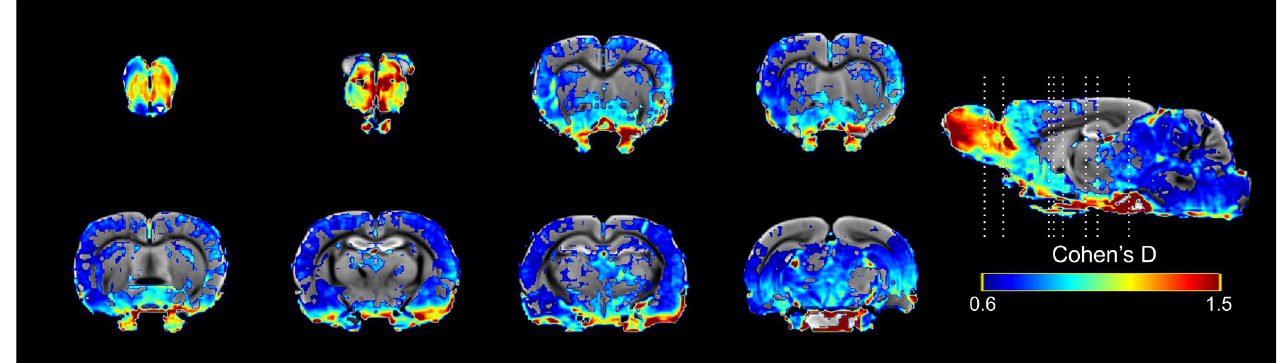
Fig 10. Results from the Cohen’s D analysis from the comparisons of control and sexual behavior from 16 mg/kg in session 10.